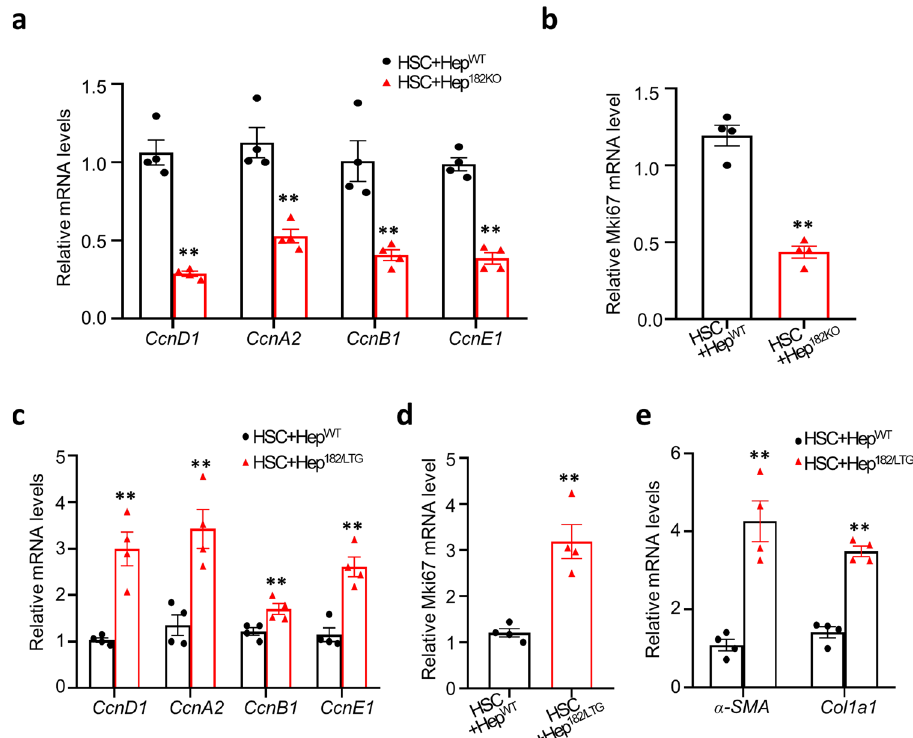
Fig. 4 miR-182-5p promotes hepatocyte proliferation via a stellate cell-dependent mechanism. qRT-PCR analyses of cyclin genes a and Mki67 b expression in primary hepatocytes from miR-182-5p KO mice (Hep 182KO ) and their control mice (Hep WT ) co-cultured with primary HSCs in the presence of EGF ( n = 6/group). Primary hepatocytes from miR-182-5p LTG mice (Hep 182/LTG ) and their control mice (Hep WT ) co-cultured with primary HSCs. qRT-PCR analyses of cyclin genes c and Mki67 gene d expression in primary hepatocytes. e qRT-PCR analyses of HSC activation marker genes expression in primary HSCs ( n = 4/group). Error bars in all experiments represent SEM; signi fi cance was determined by unpaired 2-tailed Student ’ s t test. ** P < (Supplementary Fig. 5l). Suppressing TGR5 expression by siRNA in stellate cells (Fig. 6i) greatly reduced CA-induced expression of α -SMA (Fig. 6j) and Ihh (Fig. 6k), revealing a promoting role of TGR5 in CA-induced HSC activation and hedgehog ligand production.